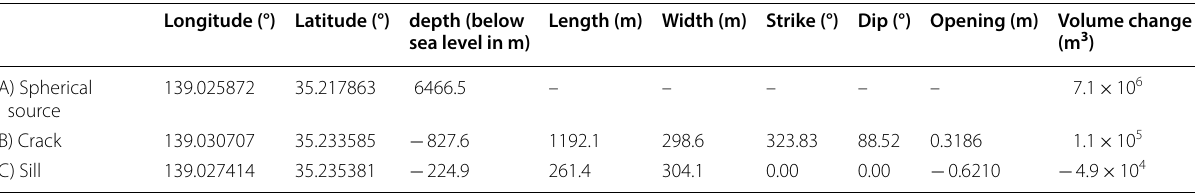
The crack and sill parameters are based on Doke et al. (2018a)